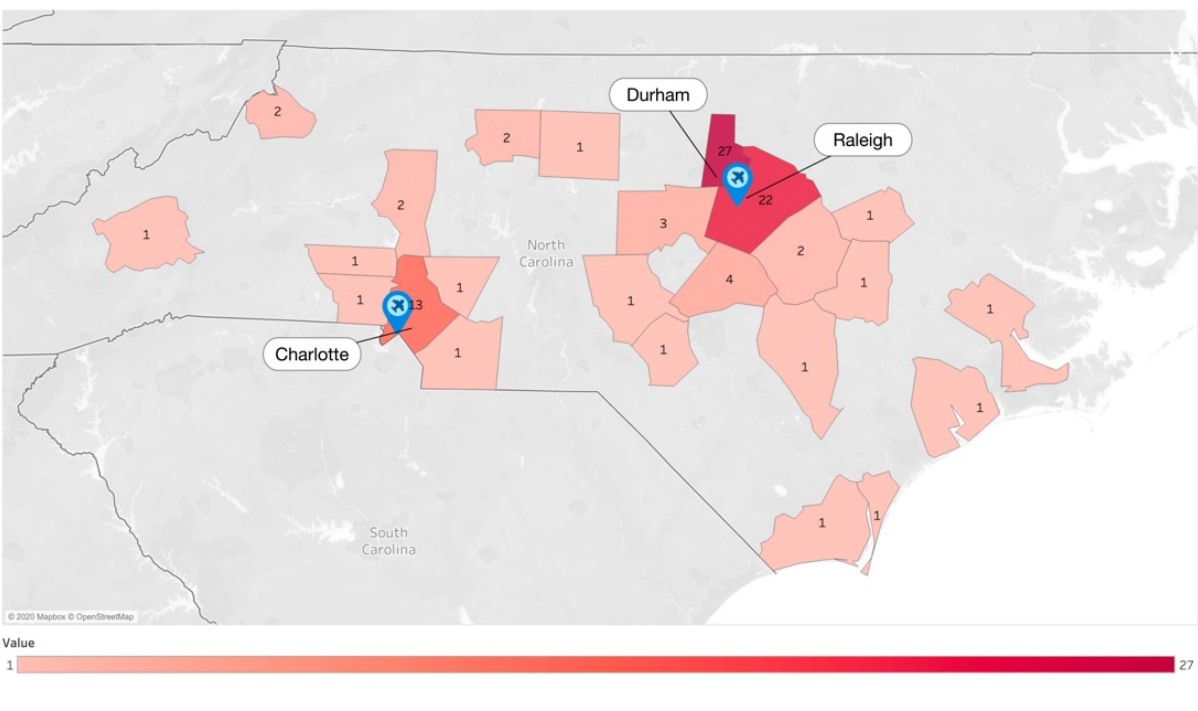
Figure 1. Mapping of North Carolina confirmed coronavirus disease cases with airport locations.